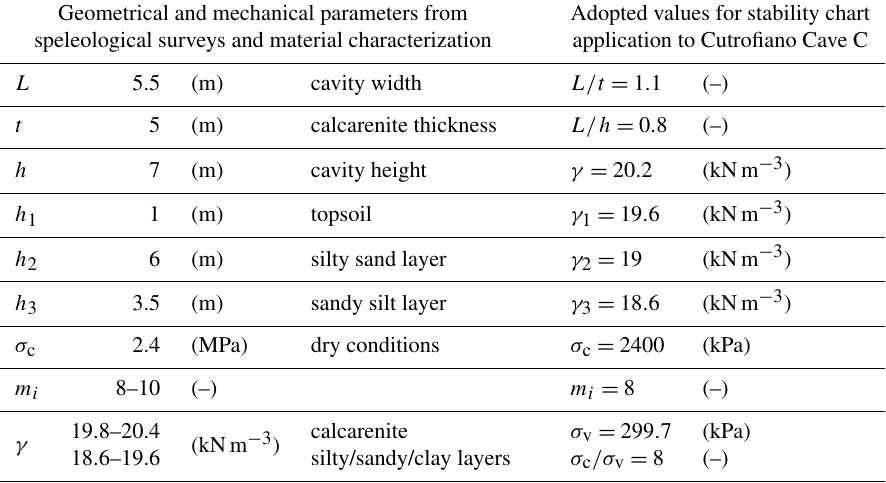
Table 7. Geometrical and mechanical parameters and adopted values for stability chart application to the underground Cutrofiano Cave C (Maglio and Ligori, 2014; Parise and Lollino, 2011). Geometrical and mechanical parameters from Adopted values for stability chart speleological surveys and material characterization application to Cutrofiano Cave